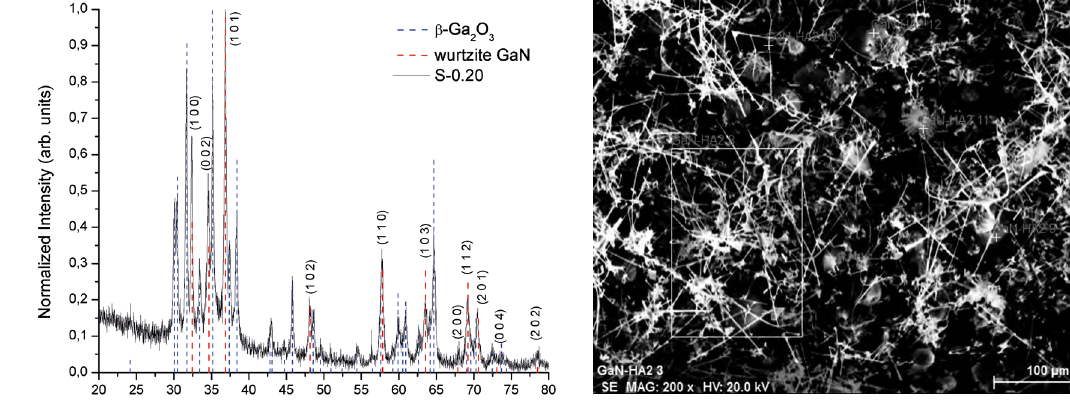
Figure 5. SEM image of sample S-0.15. The morphology is similar to sample S-0.10; however, the density of wire-like structures in Figure 3. XRD diffraction pattern of sample S-0.20. Contrary to samples S-0.15 is higher than that in S-0.10. samples S-0.10 and S-0.15, the phase of GaN is completely identified and indexed; this evidences the influence of NH OH as a synthesis 4 promoter of GaN by the ARS method. O phase fractions in sample S-0.20 according Table 2. GaN and β-Ga 2 3 to Rietveld analysis.